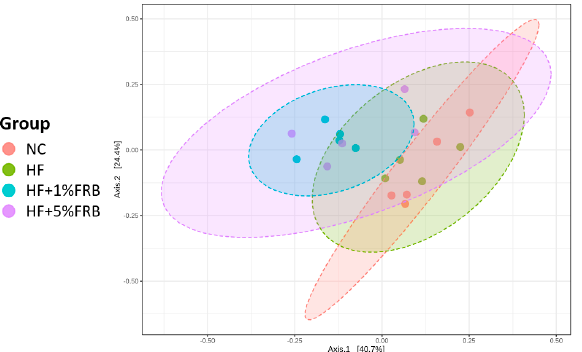
Figure 10. Effects of the water extract of fermented rice bran (FRB) on a principal coordinate analysis (PCoA) of the fecal microbiota in aged rats with high-fat (HF) diet feeding. Values are presented as the mean ± standard deviation ( n = 5).